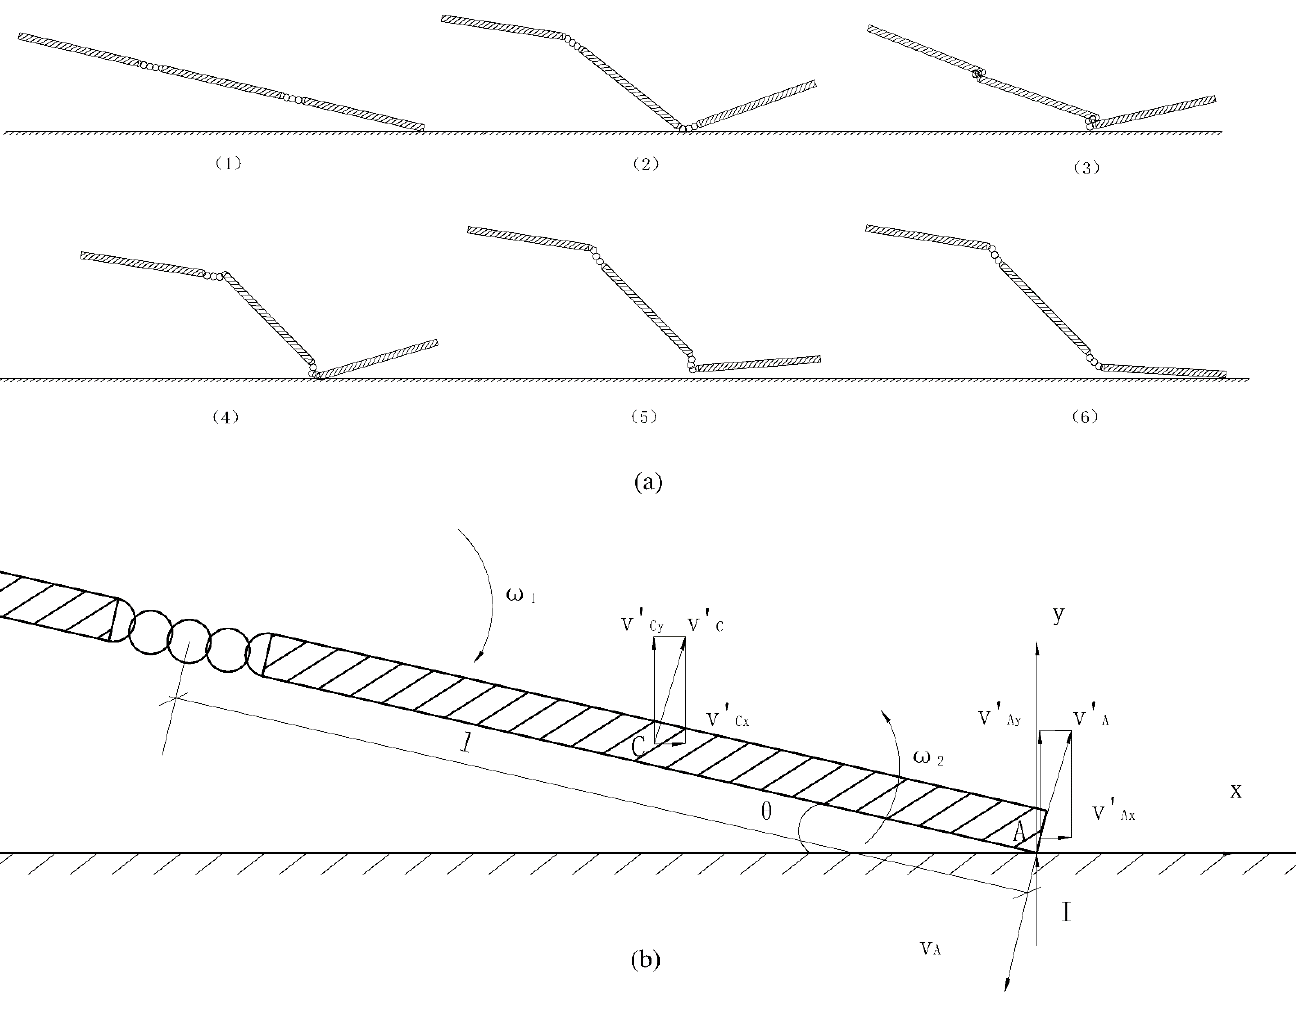
Figure 3. Three-section cudgel wrestling process ( a ) diagram and force analysis diagram ( b ).